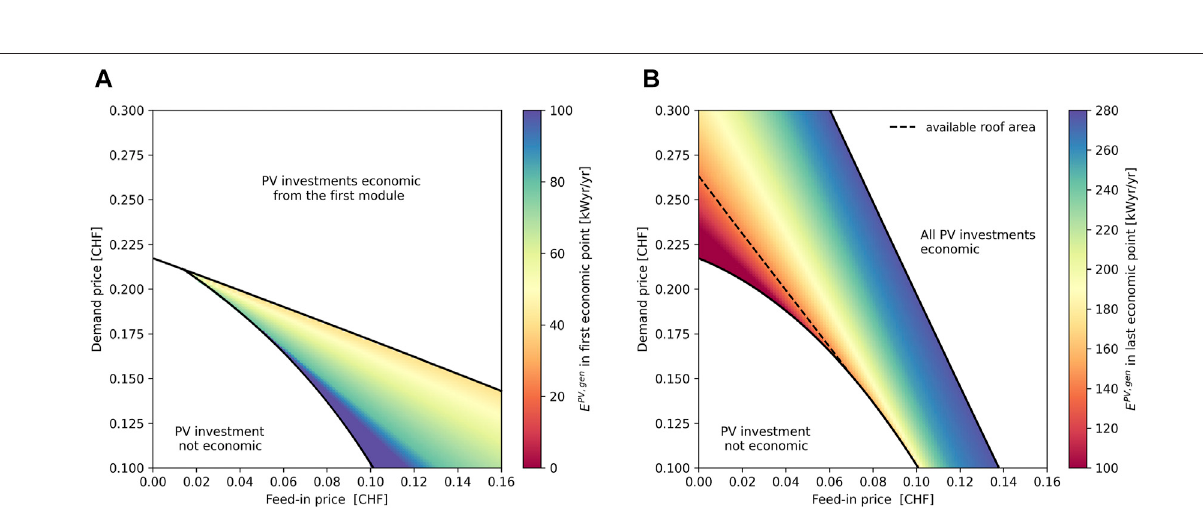
Frontiers in Energy Research |